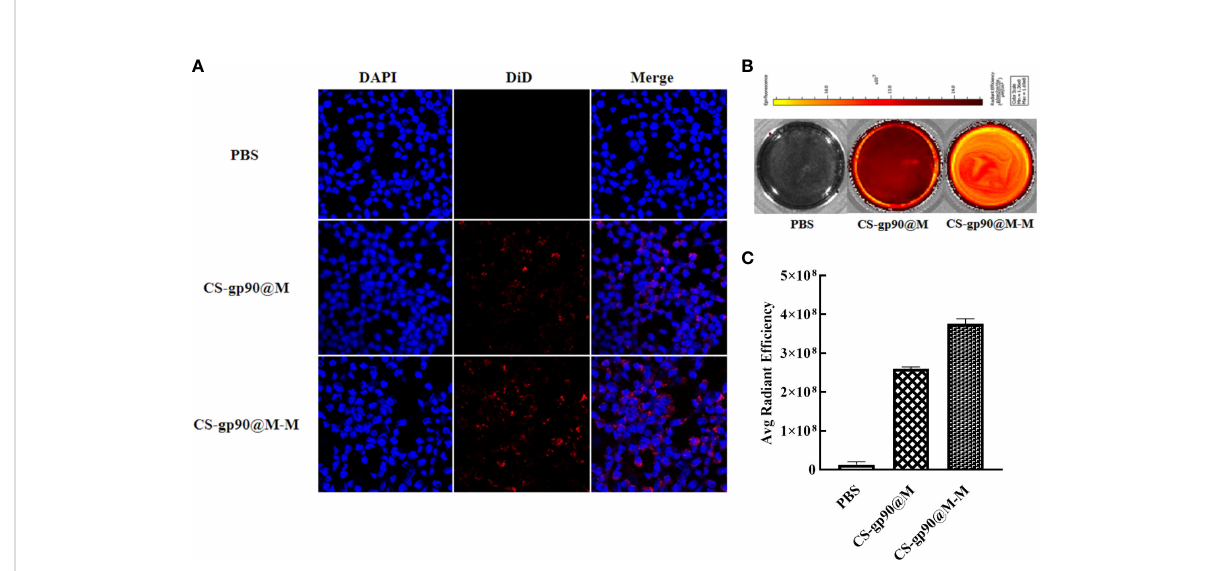
FIGURE 3 CS-gp90@M-M uptake by macrophages. (A) CLSM image of DiD-stained CS-gp90@M and CS-gp90@M-M nanoparticles up take by macrophages in vitro . Macrophage solution (8 × 10 4 cells/mL) was added to a 24-well plate, and 50 m L of DiD-stained CS-gp90@M and CS-gp90@M-M (200 m g/ mL) nanoparticles were added and incubated for 8 h. Then, the cells were stained with DAPI dye and washed twice for 20 min. The cells were mounted using glycerol (90%) and observed by CLSM. Blue fl uorescence represents DAPI-stained nuclei and red fl uorescence represents DID- stained CS-gp90@M and CS-gp90@M-M nanoparticles. (B) The uptake of CS-gp90@M-M nanoparticles by macrophages using an IVIS